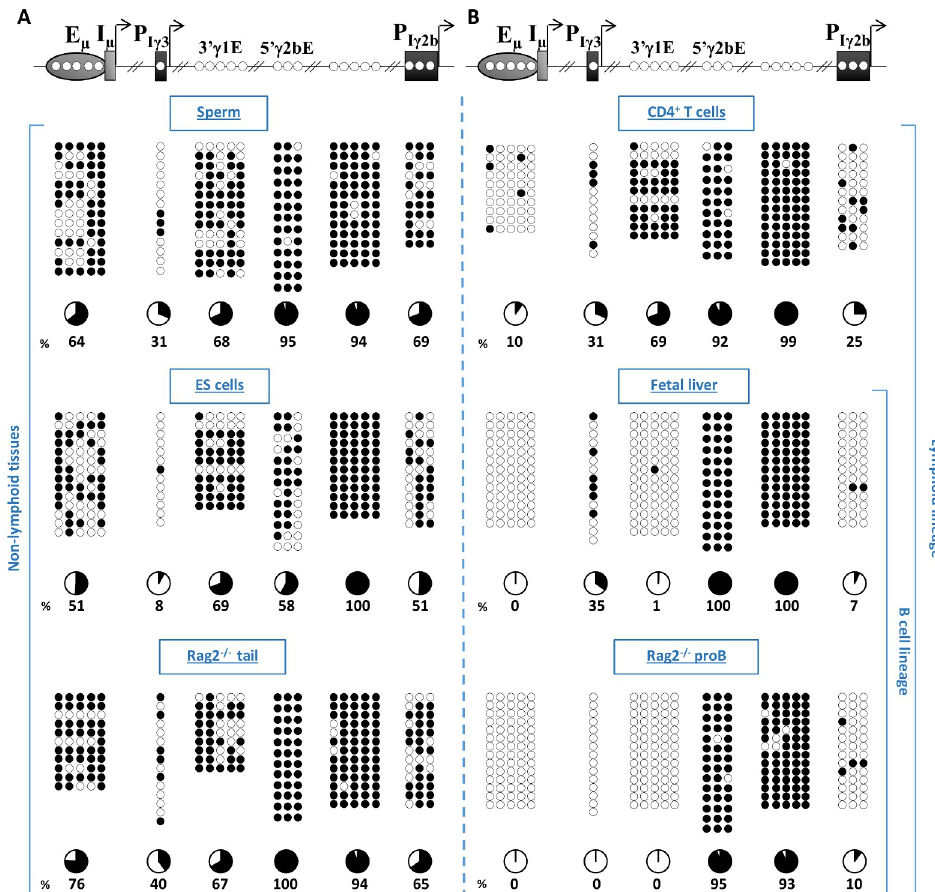
Fig 4. Methylation patterns of IgH cis -acting elements during ontogeny. The top scheme indicates the cis -acting elements mapped (E μ /I μ enhancer/GL promoter; I γ 3 and I γ 2b promoters, and 3’ γ 1E and 5’ γ 2bE). The 5 hypermethylated CpGs upstream of I γ 2b promoter (as determined in resting B cells, see Figs 1 and 2) were included as a “negative” control. For 5’ γ 2bE, only 3 CpGs (out of the 9 CpGs shown in Fig 3) were analyzed. See also the note on the distal CpG at I γ 2b promoter in the legend to Fig 1. Bisulphite sequencing maps for the indicated cis -acting elements were determined. (A) In non-lymphoid cells/tissues: mature sperm (top), ESCs (middle), tail of Rag2 - deficient mice (devoid of any circulating lymphocytes) (bottom). (B) In lymphoid cells: splenic CD4 + T cells (top), fetal liver B cells (middle), and Rag2 -deficient pro-B cells (bottom). sperm and resting splenic B cells of mice with Activation-induced cytidine deaminase (AID), Uracil DNA glycosylase (UNG), Ataxia telangiectasia mutated kinase (ATM), or the Tumor suppressor protein p53 deficiency (see discussion).